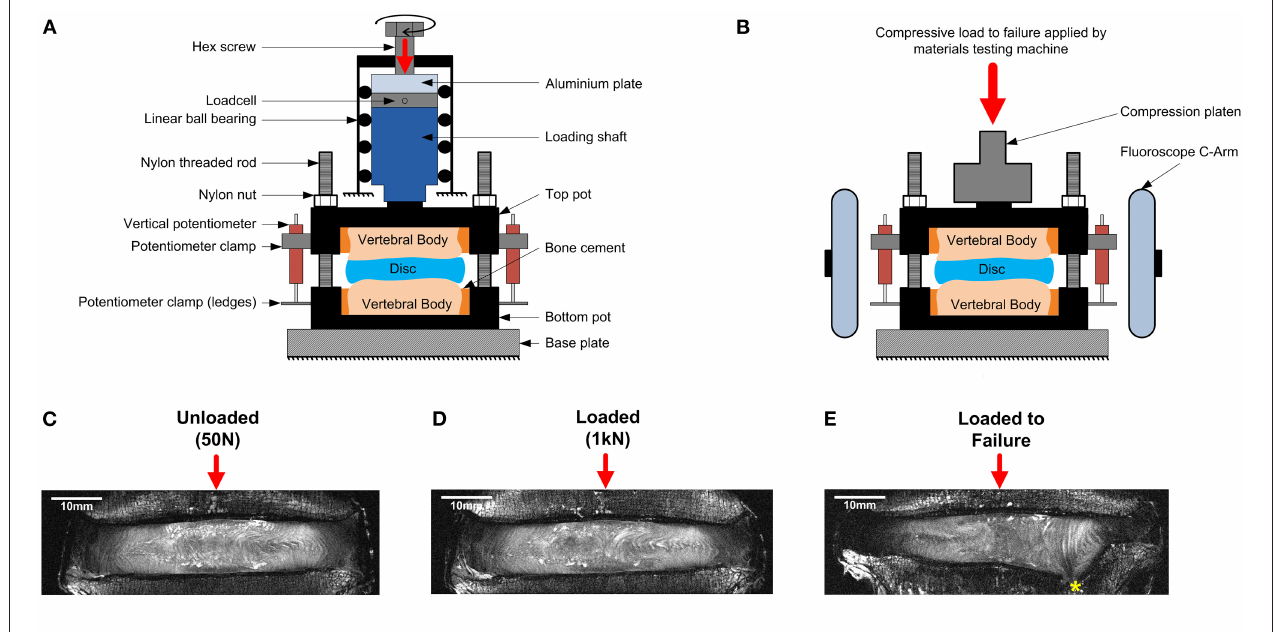
FIGURE 1 | Schematic of (A) the MRI compatible loading rig within an external custom-made screw-driven compression rig used to load samples to 50N and 1 kN, and (B) the MRI compatible loading rig within the materials testing machine used for failure tests. The applied loads were purely axial, with no bending or shear movements. A mid-coronal MRI slice of a representative degenerate sample is shown unloaded in (C) , loaded to 1kN in (D) , and after failure in (E) . The endplate fracture location is denoted by an asterisk.